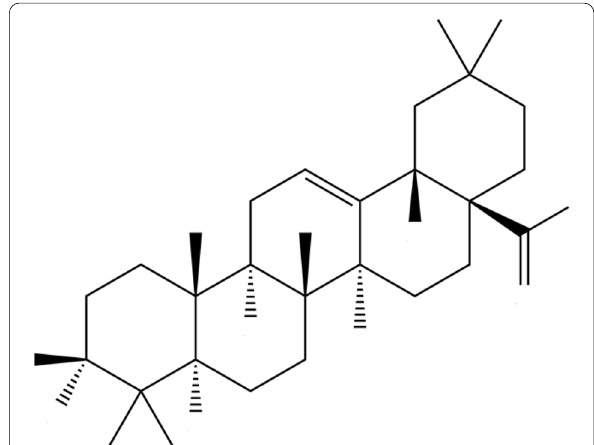
Fig. 1 Chemical structure of OA. OA is a pentacyclic triterpenoid compound that has the potential to be used in cancer therapy because it is pharmacologically